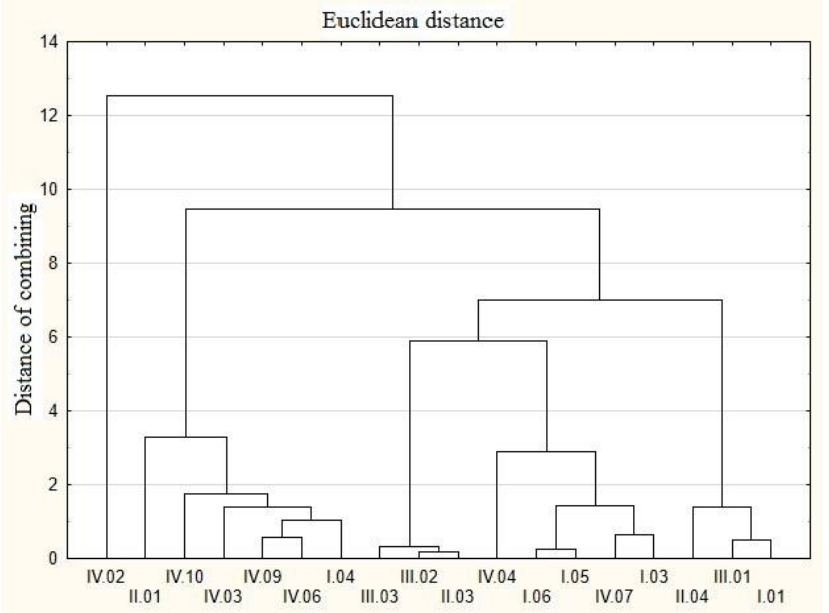
Figure 5. Key site clustering tree. The abscissa axis corresponds to the key sites and the ordinate axis corresponds to the distance of combining objects into groups (Euclidean distance). Ward’s method was used as the method of